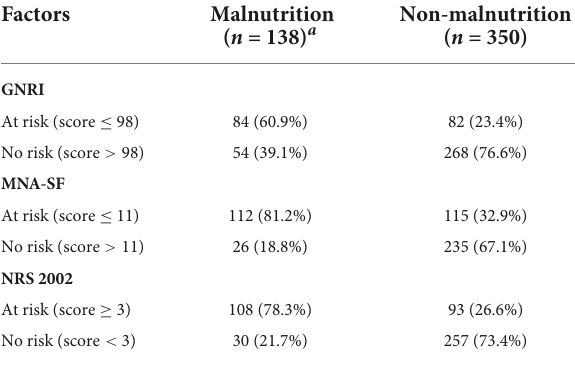
TABLE 2 Consistency between GNRI, MNA-SF, and NRS 2002 with